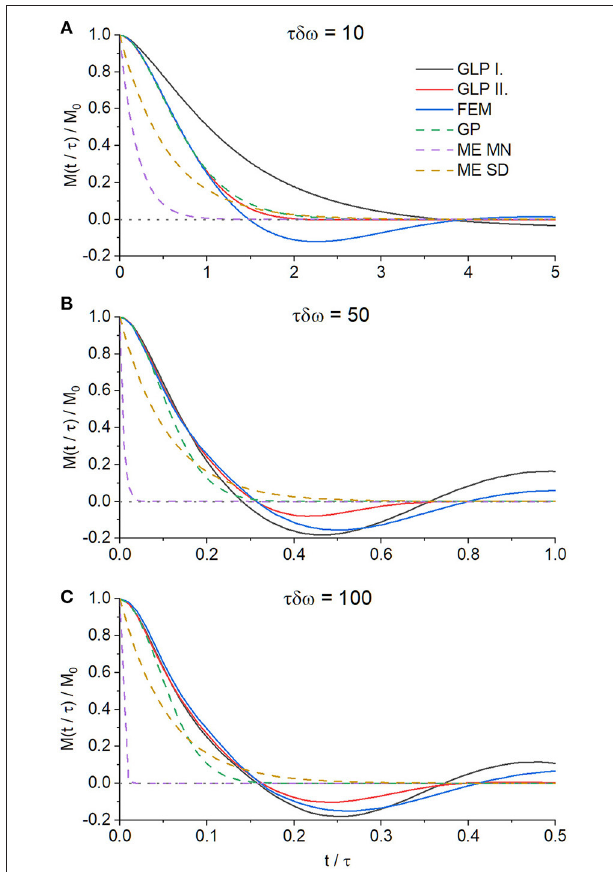
FIGURE 6 | Comparison of the total magnetization for τδω 10 (A) , = τδω 50 (B) , and τδω 100 (C) for η 0.1. Black solid line: GLP first order = = = according to Equation (85), red solid line: GLP second order according to Equation (86), blue solid line: finite element simulation of the Bloch-Torrey equation (20), green dashed line: Gaussian Phase approximation according to Equation (87), purple dashed line: monoexponential motional narrowing approximation according to Equation (91), and orange dashed line: monoexponential static dephasing approximation according to Equation (92).